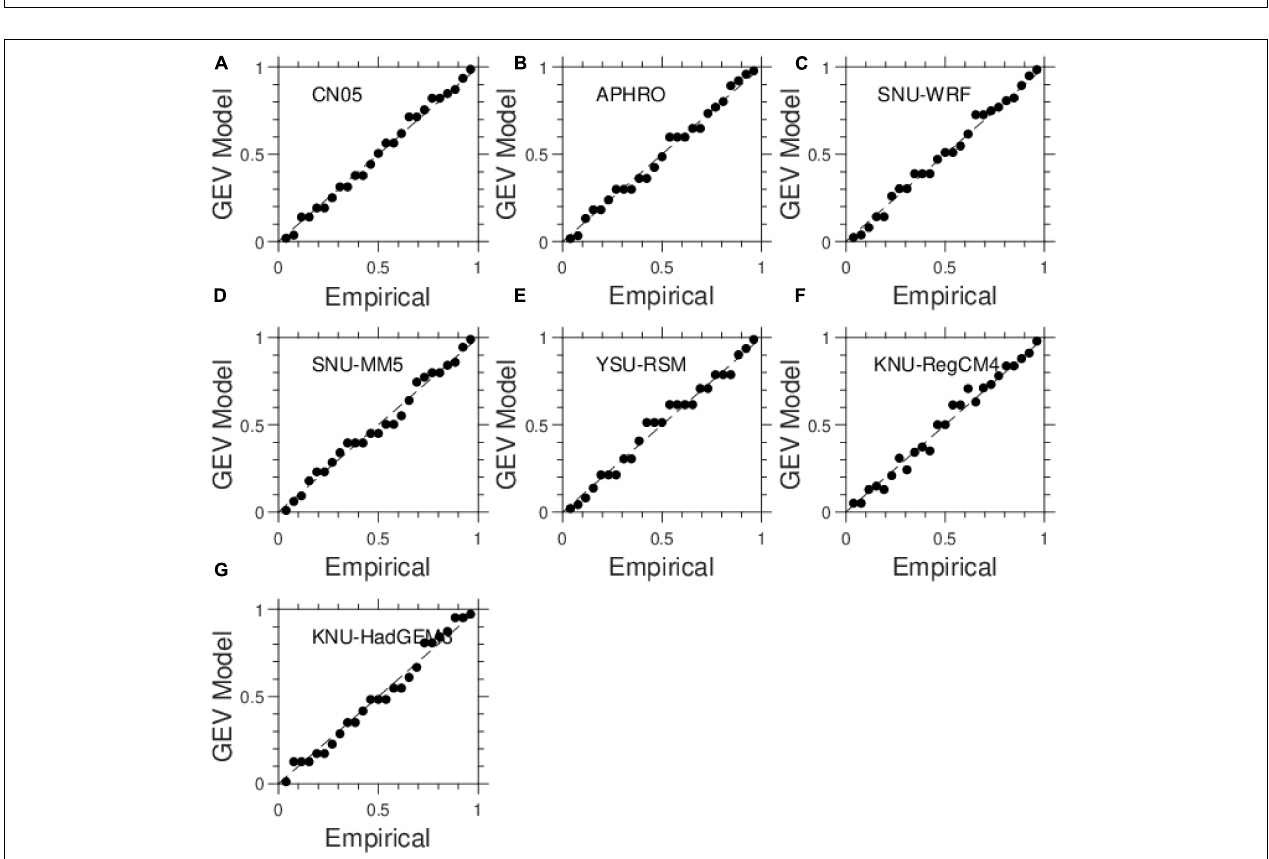
FIGURE 9 | Probabilistic–probabilistic plots of the annual AMDSL time series for cell grid at 101.75 ◦ E, 23.25 ◦ from two observations, (A) CN05 and (B) APHRO, and five RCMs, (C) SNU-WRF, (D) SNU-MM5, (E) YSM-RSM, (F) NIMR-HadGEM3, and (G) KNU-RegCM4.